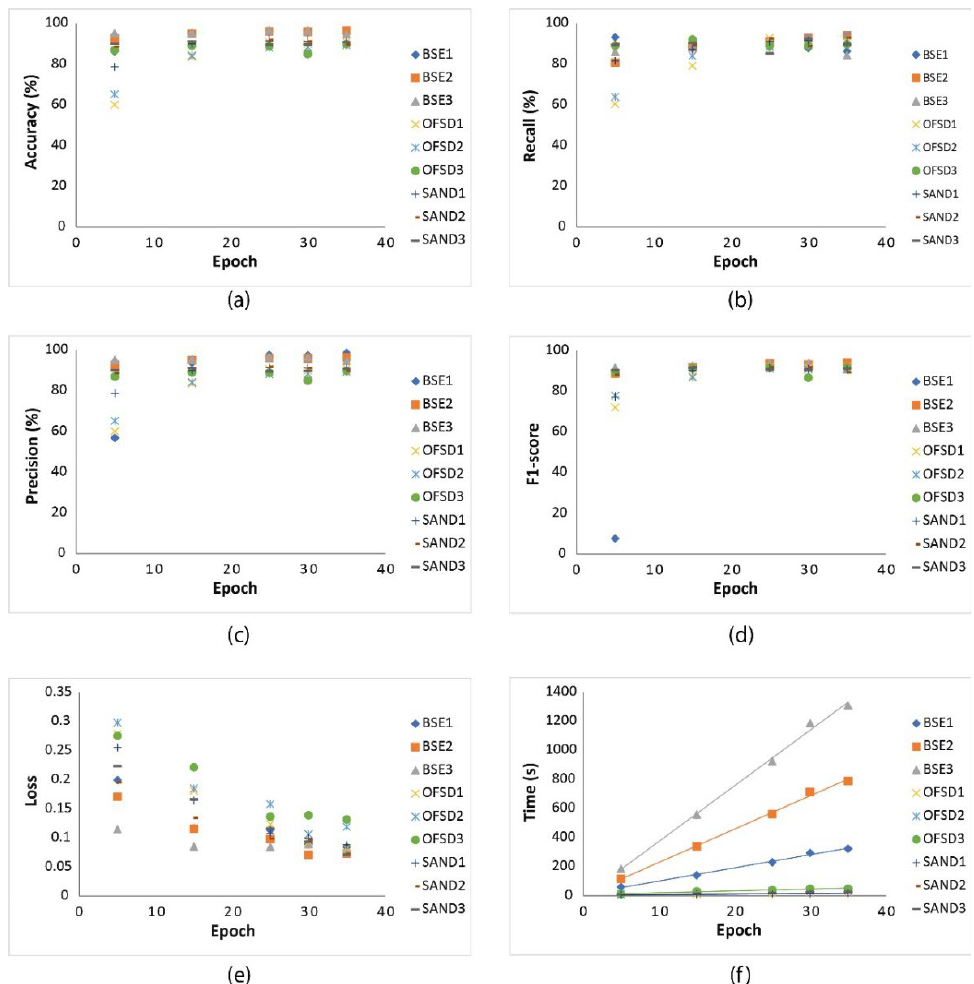
Figure 7. ( a ) The changes of accuracy as the epoch varies from 5 to 35 for the nine groups of BSE1, BSE2, BSE3, OFSD1, OFSD2, OFSD3, SAND1, SAND2, and SAND3. ( b ) The change of recall as the epoch varies from 5 to 35 for the nine groups. ( c ) The change of precision as the epoch varies from 5 to 35 for the nine groups. ( d ) The changes of F1-score as the epoch varies from 5 to 35 for the nine groups. ( e ) The changes of loss as the epoch varies from 5 to 35 for the six groups. ( f ) Time of training changes vs. epoch changes for the nine groups.